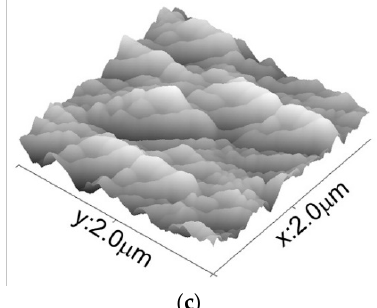
Figure 8. CaP coatings deposited on Si at a working gas pressure of 0.8 mTorr under inclination angles of 0° ( a ) and 80° ( b ) and 3D visualization of coating deposited under 80° ( c ).